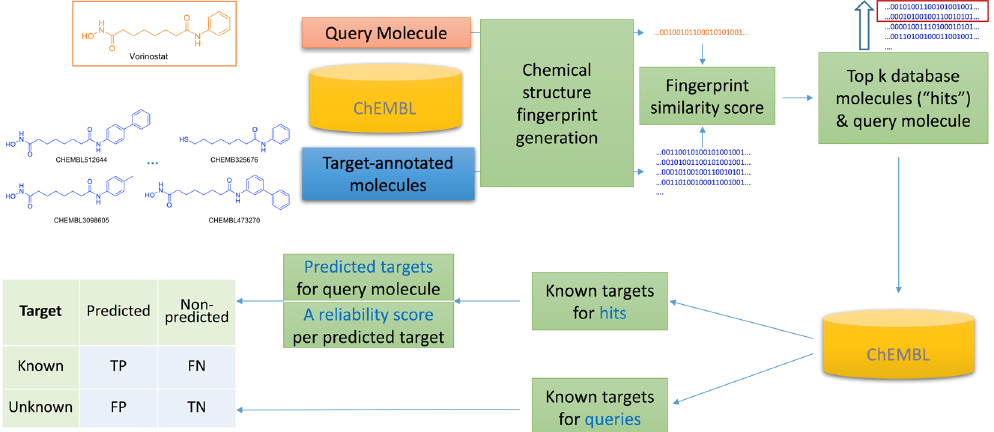
Figure 1. Ligand-centric target prediction workflow. The selected molecular similarity method is used to find the top k most similar database molecules to the query molecule (vorinostat in this illustrative example). Known targets for the query and the top k hit molecules are retrieved from the ChEMBL database. A novel method is introduced to assign a reliability score for each query-target association prediction based on the proportion of the query’s top hits binding to the predicted target. Lastly, the known targets of the query molecule permit measuring the predictive performance of the method at each reliability level in this binary classification